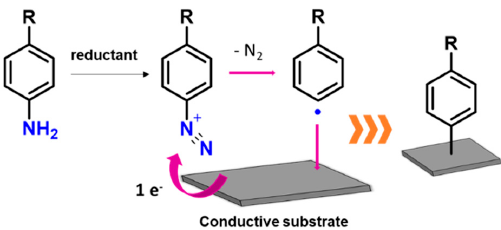
Figure 4. Scheme showing the electrografting process for a diazonium salt.